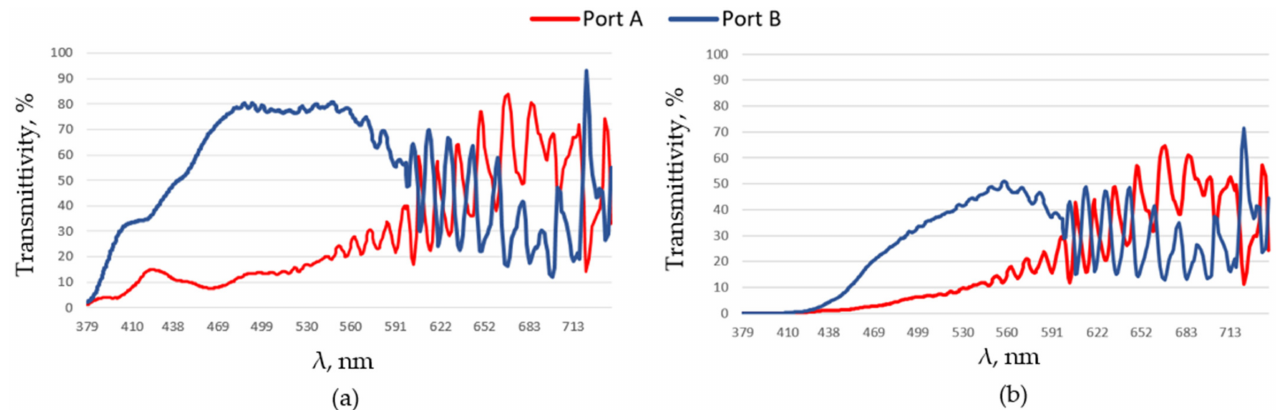
Figure 3. Transmittance for the full visible spectrum at normal incidence and different positions of the ports inside the silicon layer: ( a ) d A = d B = 100 nm; ( b ) d A = d B = 1500